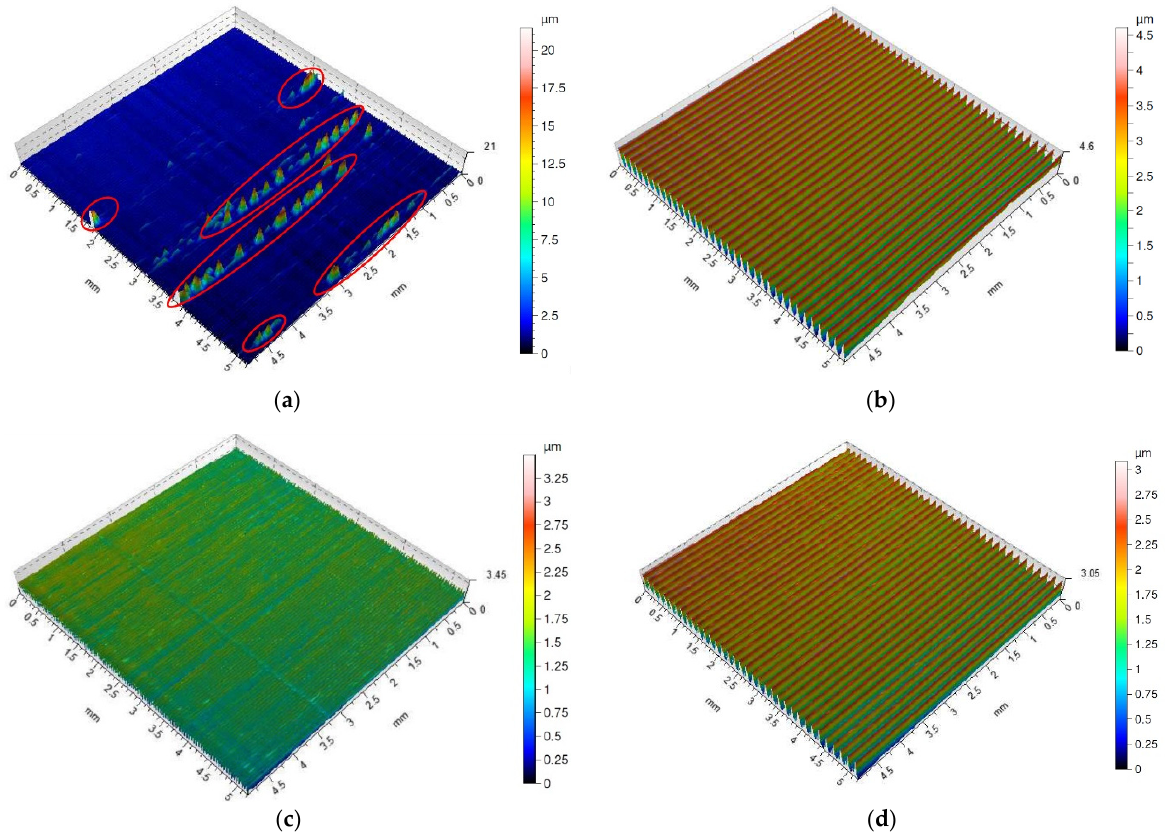
Figure 15. Surface topography of Inconel 718 after turning by conventional insert ( the sticking on machined surface is marked by red circle) . ( a ) dry cutting, f = 0.05 mm/rev; ( b ) dry cutting, f = 0.15 mm/rev; ( c ) wet cutting, f = 0.05 mm/rev; ( d ) wet cutting, f = 0.15 mm/rev.